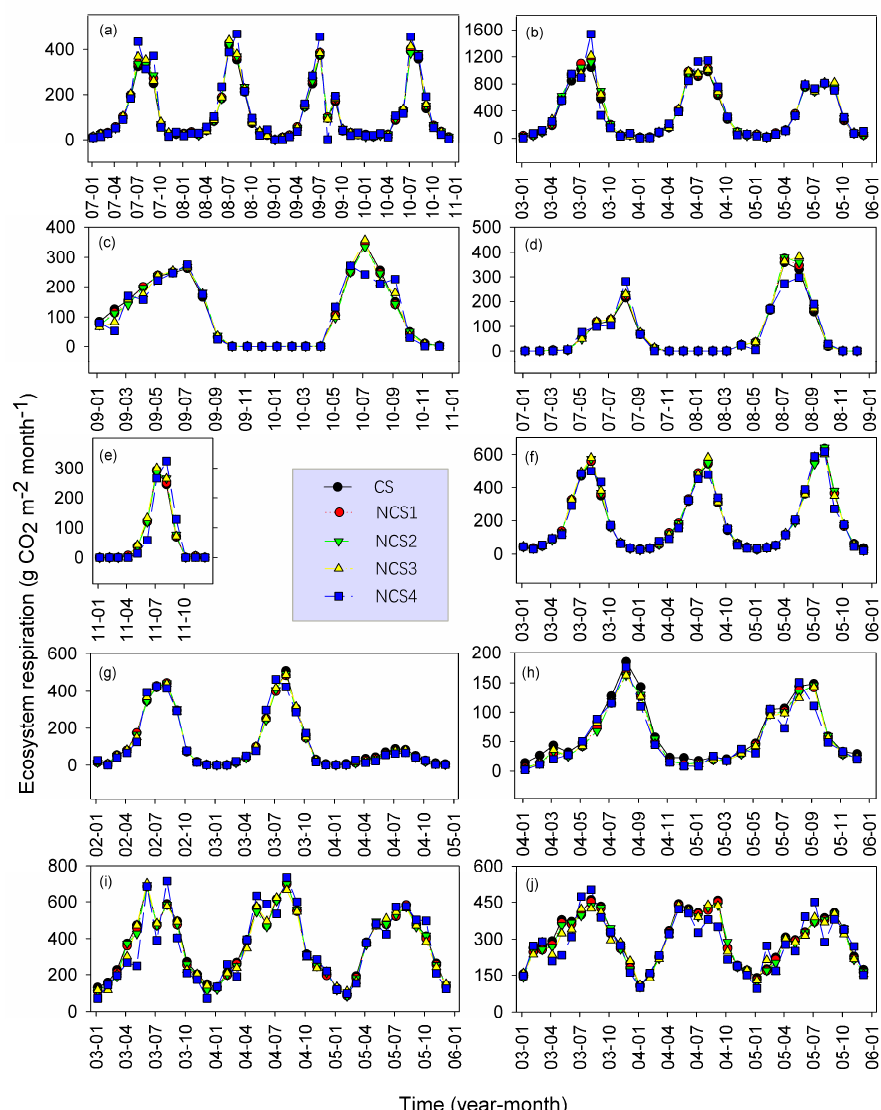
Figure 11. Comparison of monthly ecosystem respirations among continuous (CS) and non-continuous sampling (NCS) using eddy covariance data. ( a ) Changling Grasslands; ( b ) Changbaishan Forest; see [58,59] for explanation on the high respiration; ( c ) Duolun Degraded Meadow; ( d ) Duolun Grassland; ( e ) Siziwang Grazed Grassland; ( f ) Haibei Permanent Wetland; ( g ) Haibei Grasslands; ( h ) Dangxiong Grassland; ( i ) Qianyanzhou Forest; ( j ) Dinghushan Forest. See Table 2 for more information. Data of NCS were generated by selecting observations from CS at different frequencies. CS are the eddy covariance timeseries and the NCS are the up-scaled calculated monthly sums using different half-hour emissions. CS: sum of all observations, i.e., 48 half-hour observations per day (48 observations per day * 30 days = 1440 observations per month). NCS1: calculated using 1 half-hour observation per day (1 observation per day * 30 days = 30 observations per month); as a common sampling time of manual chamber method [60,61], observation of 9:00–9:30 a.m. was selected as an example. NCS2: